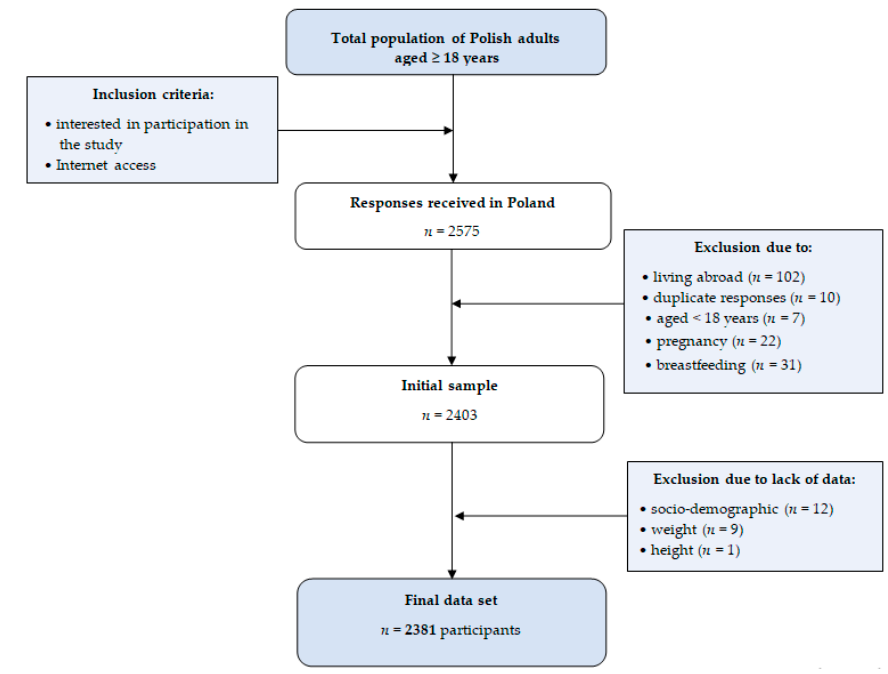
Figure 1. Sample collection chart.